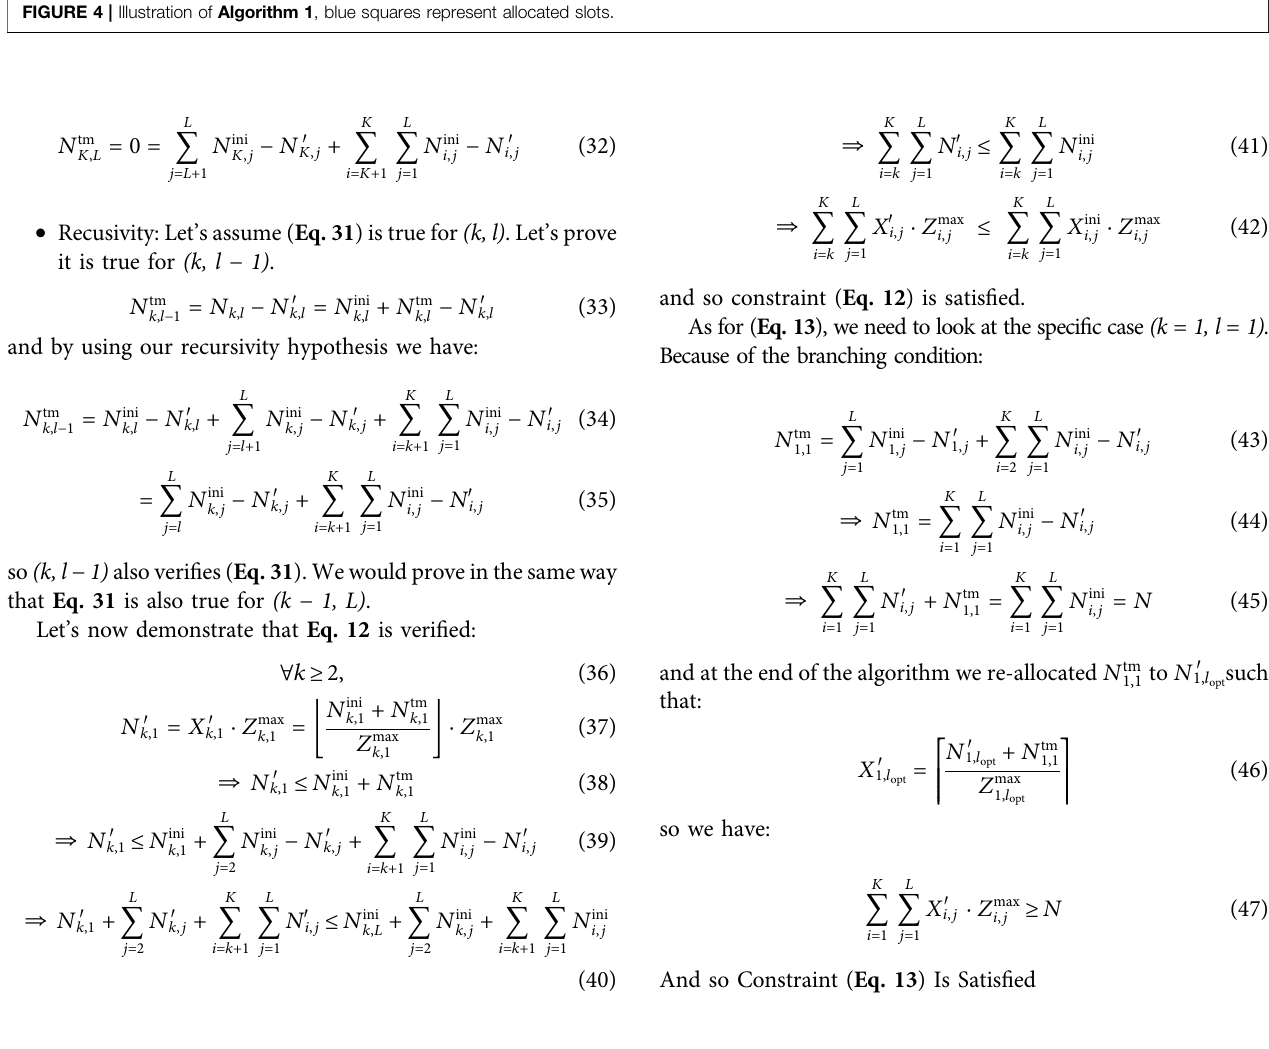
FIGURE 4 | Illustration of Algorithm 1 , blue squares represent allocated